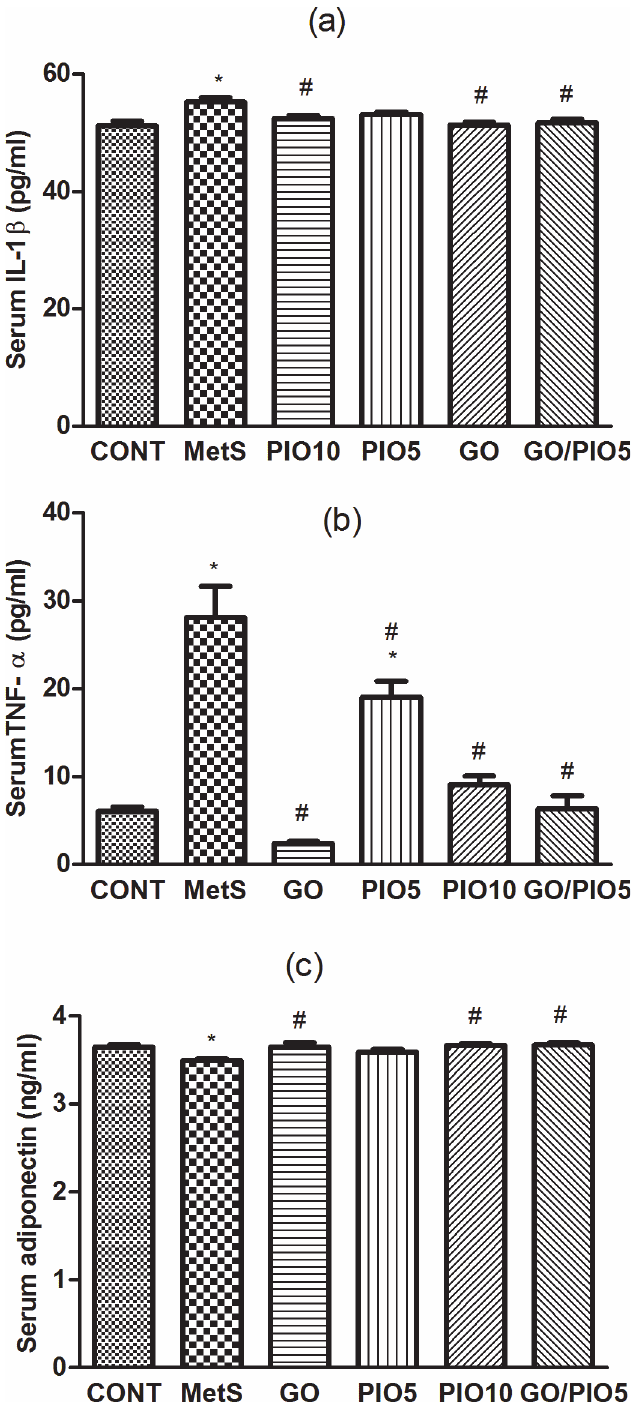
Fig 5. Effect of 4 weeks daily oral administration of geraniol (GO; 250 mg/kg), pioglitazone (PIO; 5 and10 mg/kg), and GO with PIO5 on serum (a) interleukin (IL)-1 β , (b) tumor necrosis factor (TNF)- α , and (c) adiponectin levels in fructose-induced metabolic syndrome (MetS) in rats. Values are mean (6 – 8 animals) ± SEM. P < 0.05, as compared to control (CONT) ( * ) and MetS ( # ) groups using one-way ANOVA followed by Tukey – Kramer